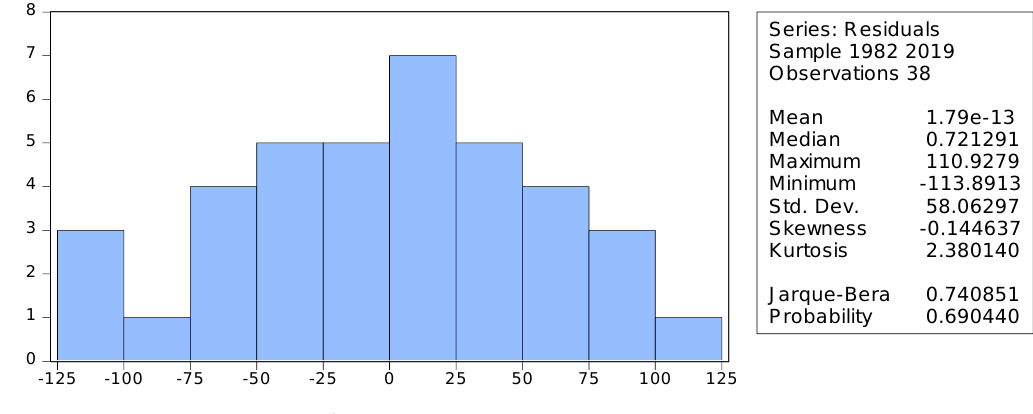
Figure 5: Jarque-Bera Residual Normality Test